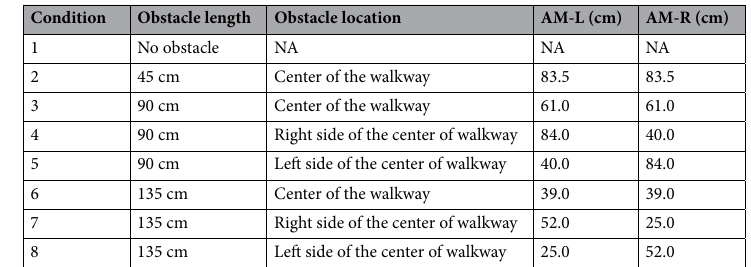
Table 1. Obstacle conditions. AM-L represents the left avoidance margin; AM-R represents the right avoidance margin.